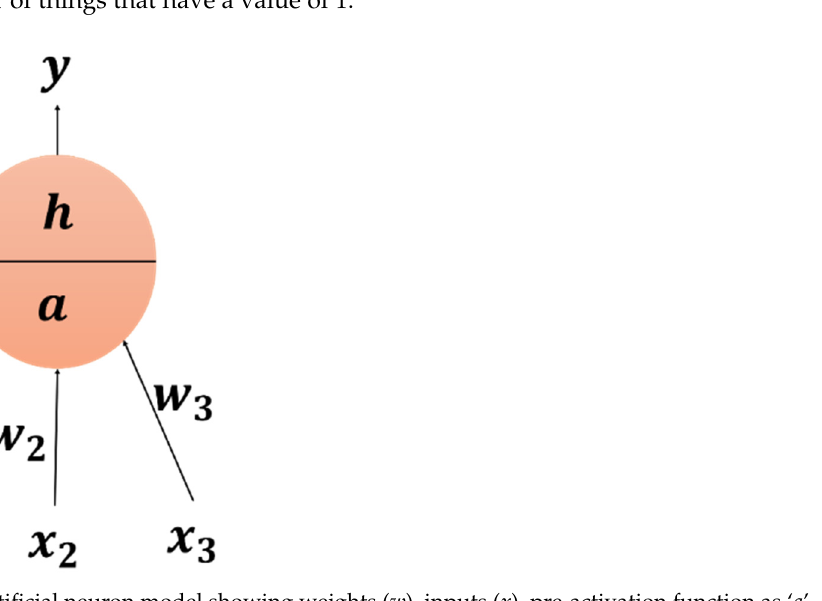
Figure 1. Artificial neuron model showing weights ( w ), inputs ( x ), pre-activation function as ‘ a ’, and activation function ‘ h ’ and ‘ y ’ as outputs.